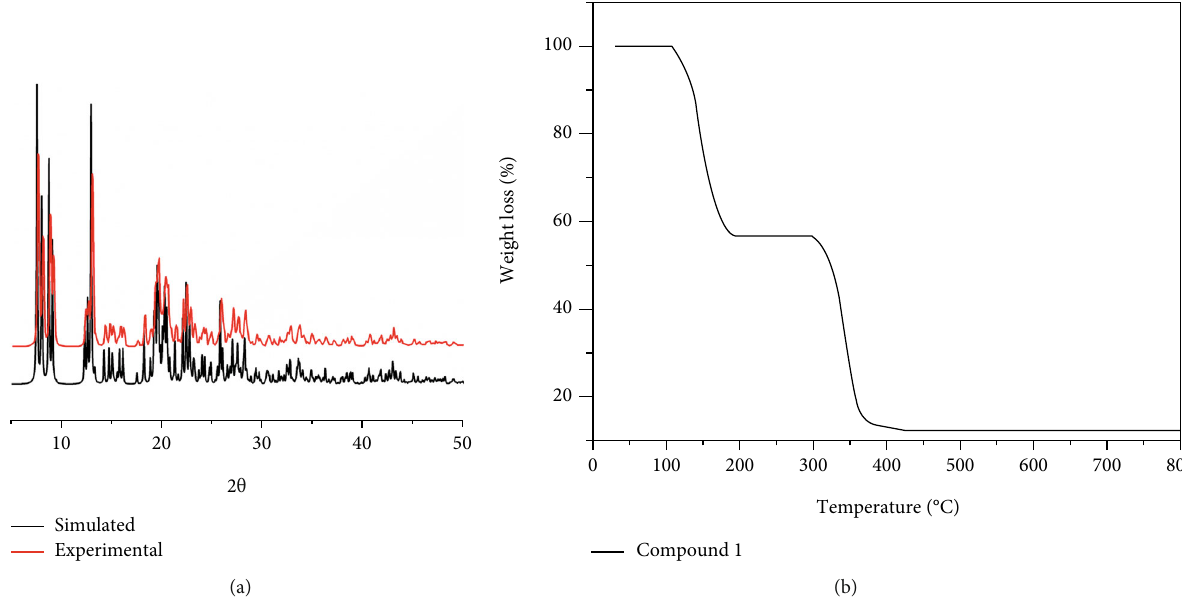
Figure 2: (a) PXRD modes for 1. (b) TGA curve for 1.